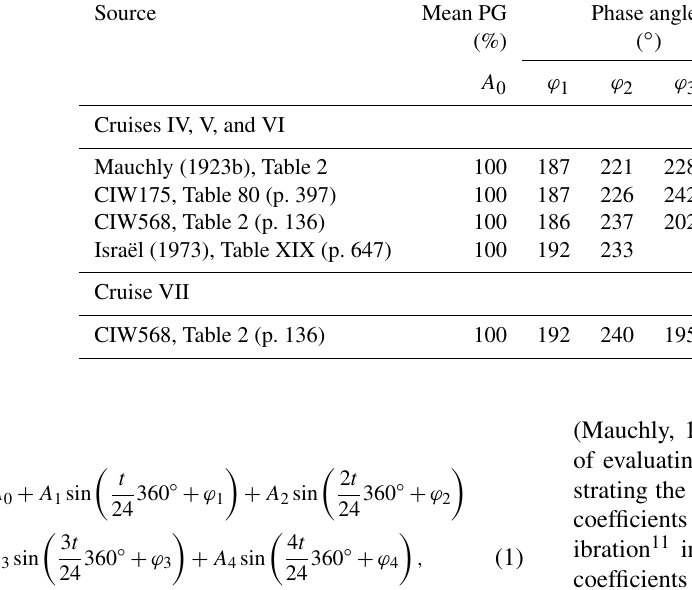
Table 1. Annual harmonic coefficients from Carnegie PG data: relative variation.